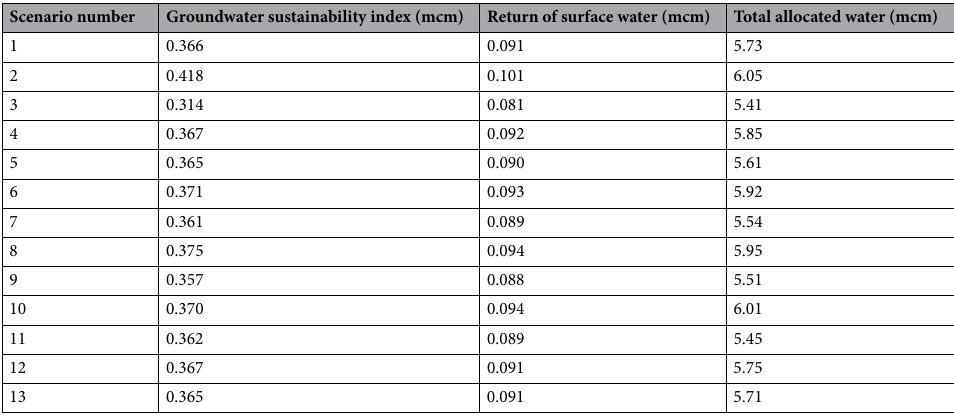
Table 5. Simulated water characteristics for the 13 scenarios.